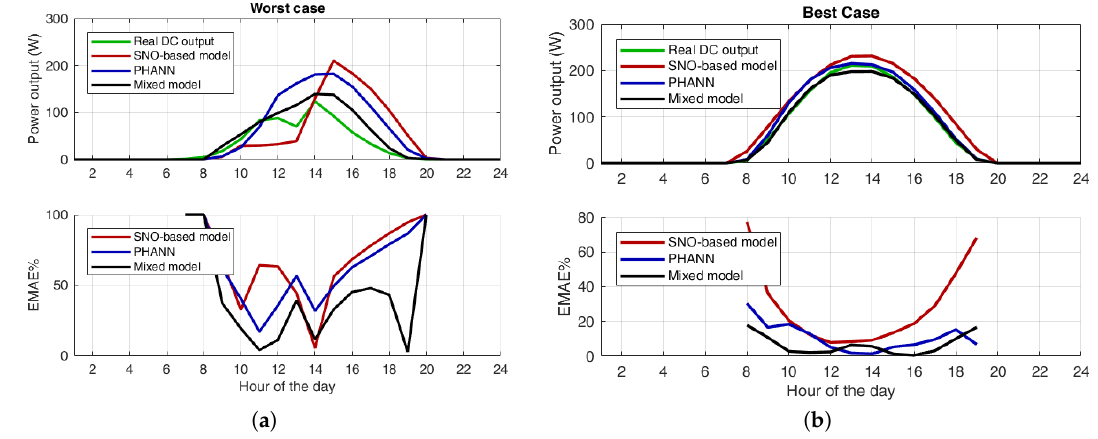
Figure 11. Comparison between the SNO-based model, the PHANN and the mixed model on the best and the worst days in terms of power output and EMAE % error trend: ( a ) Worst performance day; and ( b ) Best performance day.